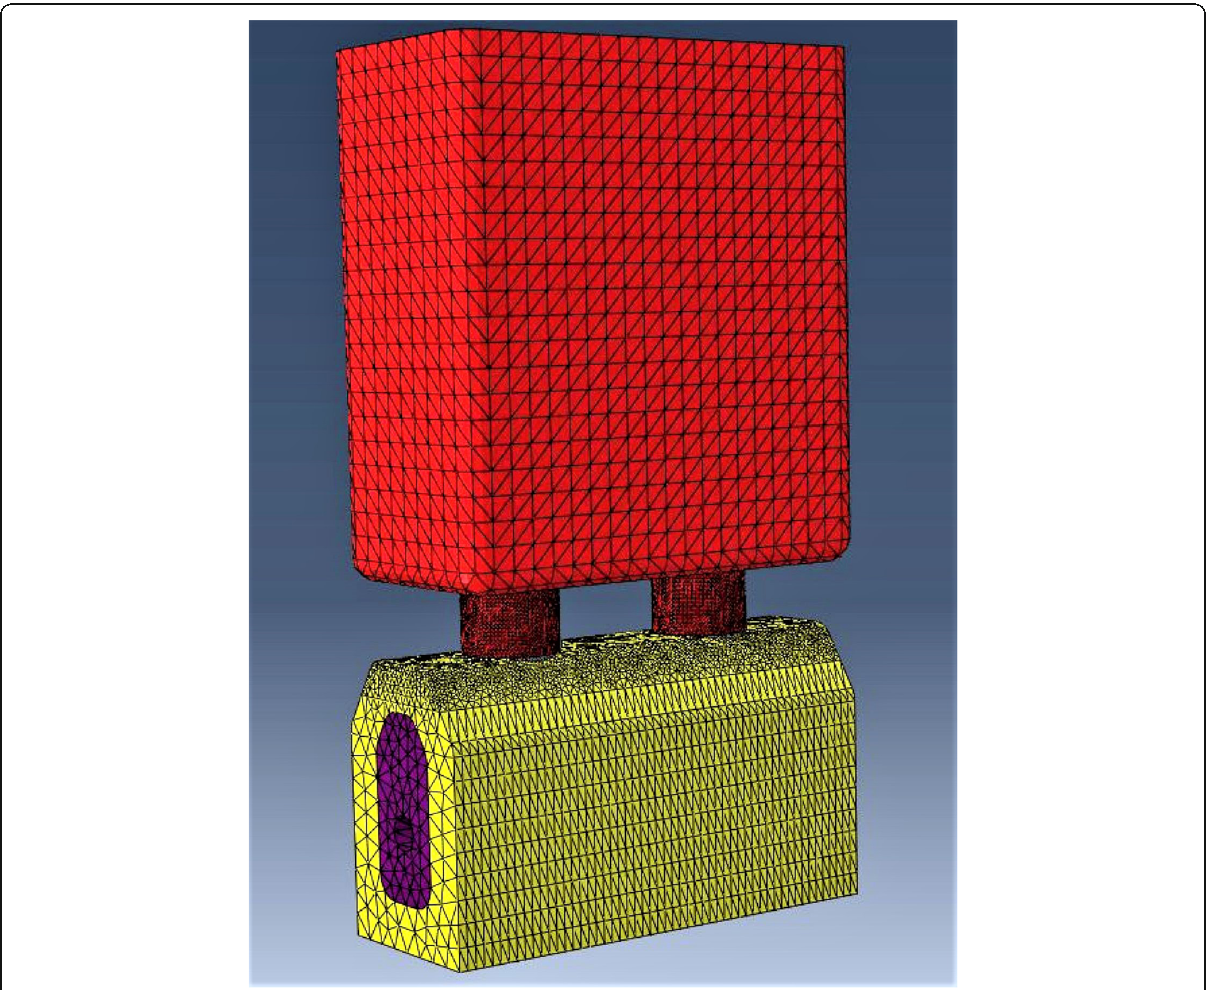
Fig. 2 Numerical model discretization where an area with a refined mesh at the marginal bone and prosthetic connectors can be